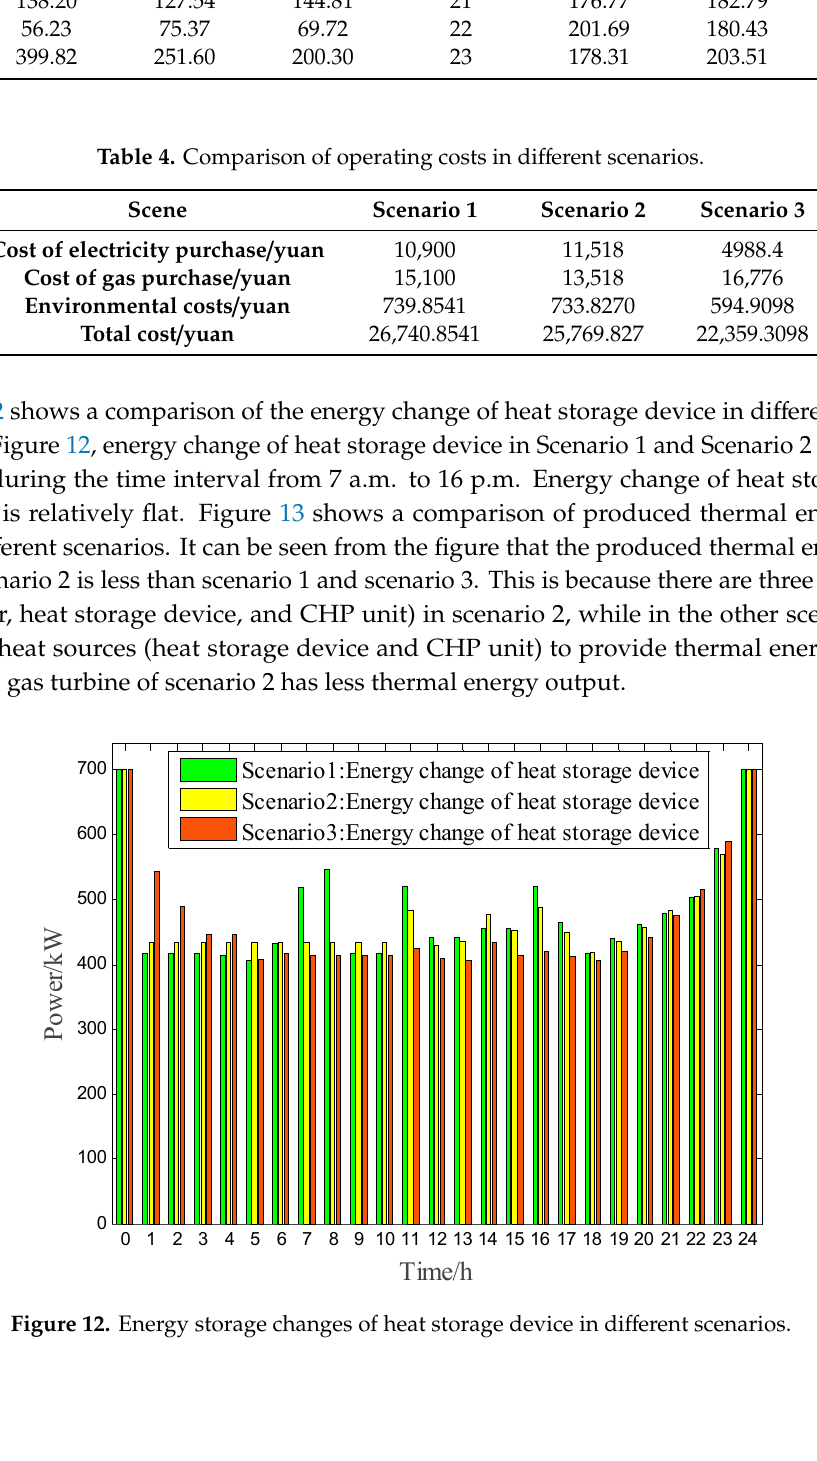
Figure 13. Output thermal energy of gas turbine in different scenarios. Figure 14 shows the total wind power accommodation of scenario 3 (i.e., CEGBCS proposed in this paper). It can be seen from the figure that the wind power in the system is divided into two parts for accommodation. First, through coordinated optimal operation, the electric load in the system can accommodate wind power as much as possible. Then the remaining wind power, which cannot be accommodated by electric load, is used by P2G to produce natural gas.